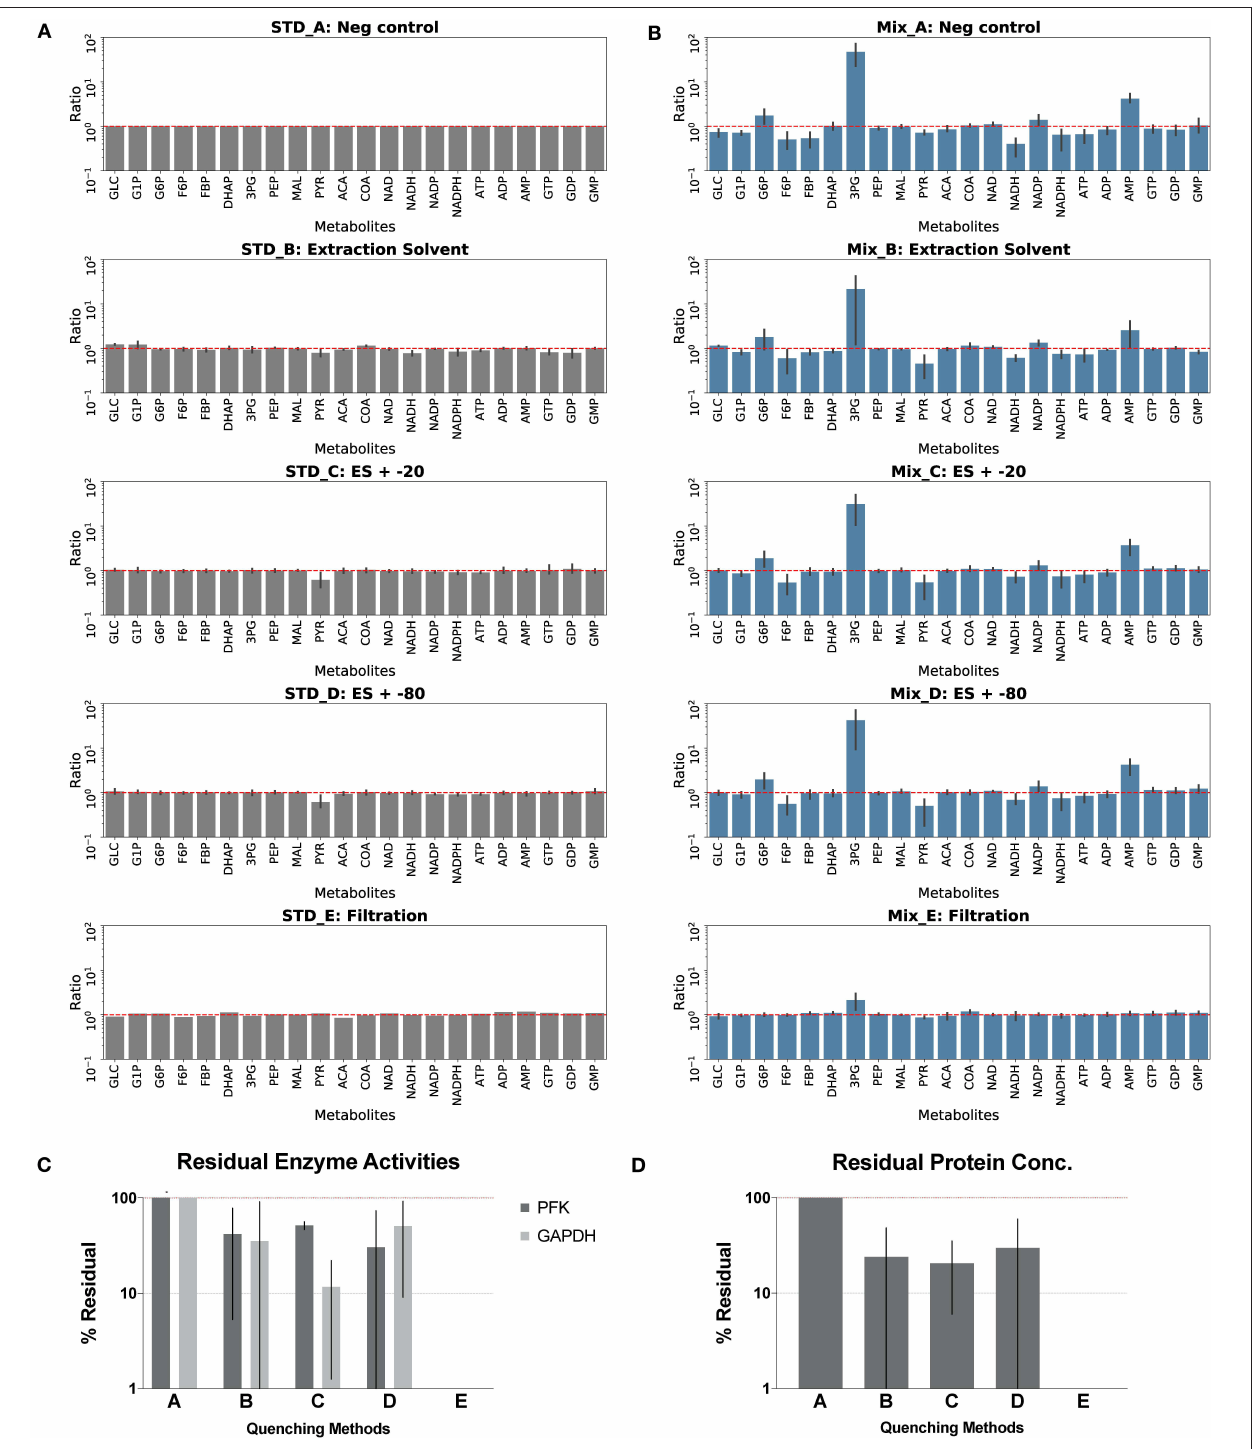
FIGURE 4 | Assessment of quenching methods. Quenching methods A–E are: no-quenching control method A quenched with cold solvent (2:2:1 acetonitrile:methanol:water) and kept at 4 ◦ C overnight method B CFER quenched with cold solvent and kept at − 20 ◦ C overnight method C CFER quenched with cold solvent and kept at − 80 ◦ C overnight method D CFER filtered by Amicon Ultra 3K protein filter, method E. See Figure 1 for metabolite abbreviations. (A) Degradation of components of the standard mix is shown. Standards were treated with four different quenching methods, and the metabolite concentrations after treatment was compared to the no-quenching control (STD_A). Error bars represent one standard deviation (N = 4). Red dashed line indicates no degradation. (B) Post-quenching metabolite interconversion due to residual enzyme activity. CFER samples quenched by four methods were mixed with standards containing 500 µ M of